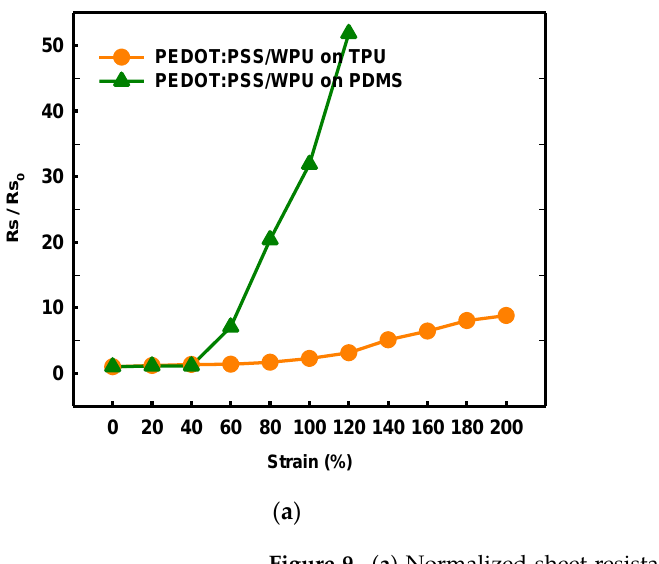
Figure 9. ( a ) Normalized sheet resistance of PEDOT:PSS/nonionic WPU (2.0 wt%) on TPU film and PEDOT:PSS/nonionic WPU on PDMS under strain from 0% to 200%. ( b ) Scanning electron microscope images of PEDOT:PSS/nonionic WPU (2.0 wt%) on TPU film and PEDOT:PSS/nonionic WPU on PDMS after strain and release with 50 and 100% strain.